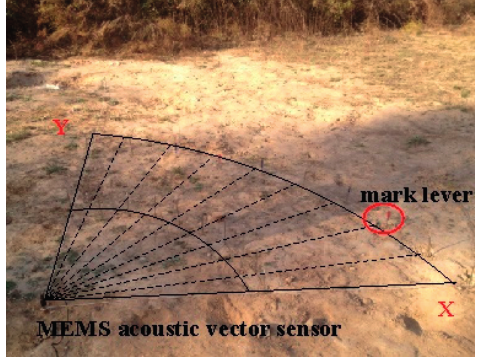
Figure 11. Experiment site.